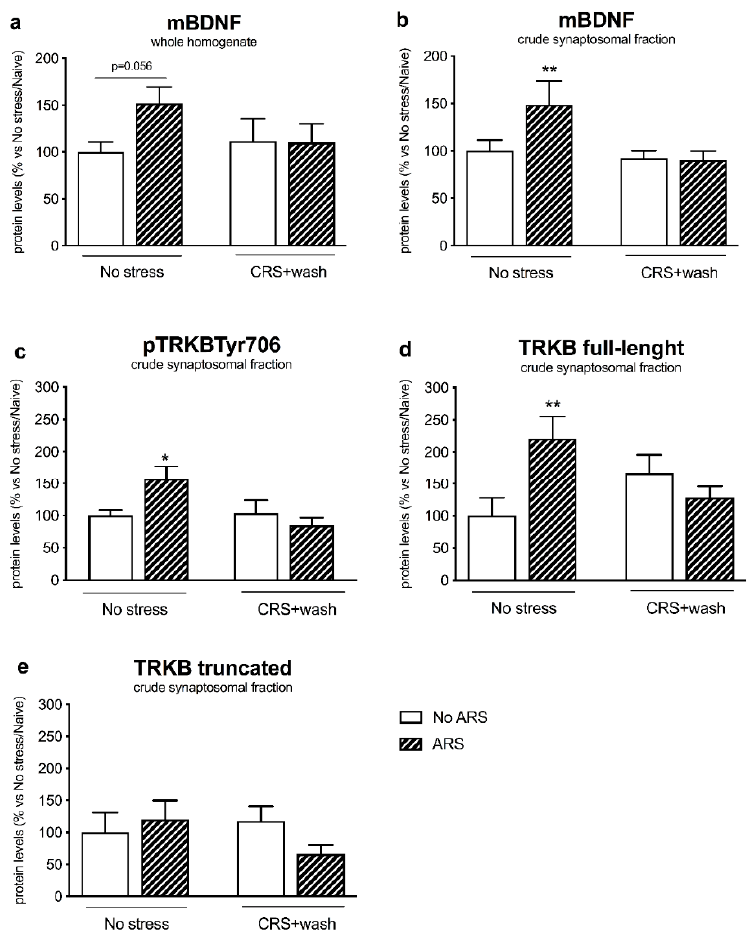
Figure 3. Analysis of mature brain-derived neurotrophic factor (mBDNF) (panels a , b ) and TRKB receptor (phosphorylated, full-length and truncated form) (panels c – e ) protein levels in the prefrontal cortex of chronically stressed rats (CRS) exposed to an acute challenge (ARS) after 3 weeks of washout (wash). The data, expressed as a percent change of No stress / No ARS animals, are the mean ± SEM. * p < 0.05, ** p < 0.01 vs. No stress / No ARS (two-way ANOVA with PLSD).